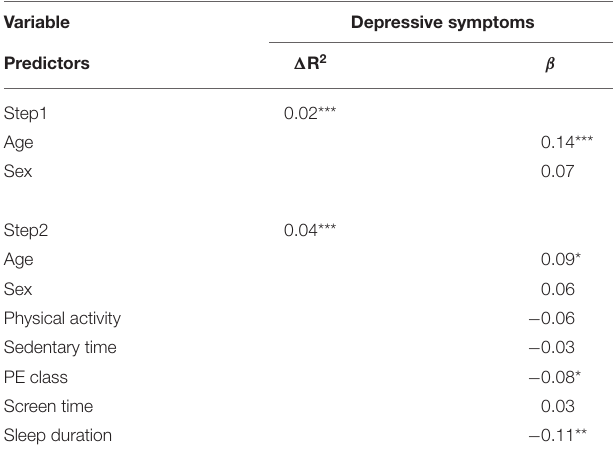
TABLE 2 | Hierarchical regressions for the depressive symptoms.